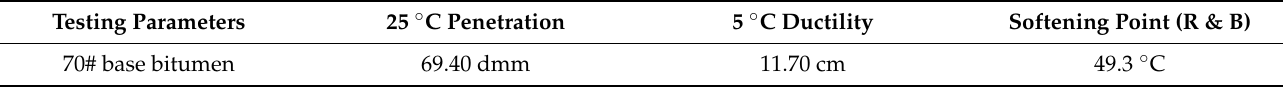
Table 1. Physical performance of 70# base